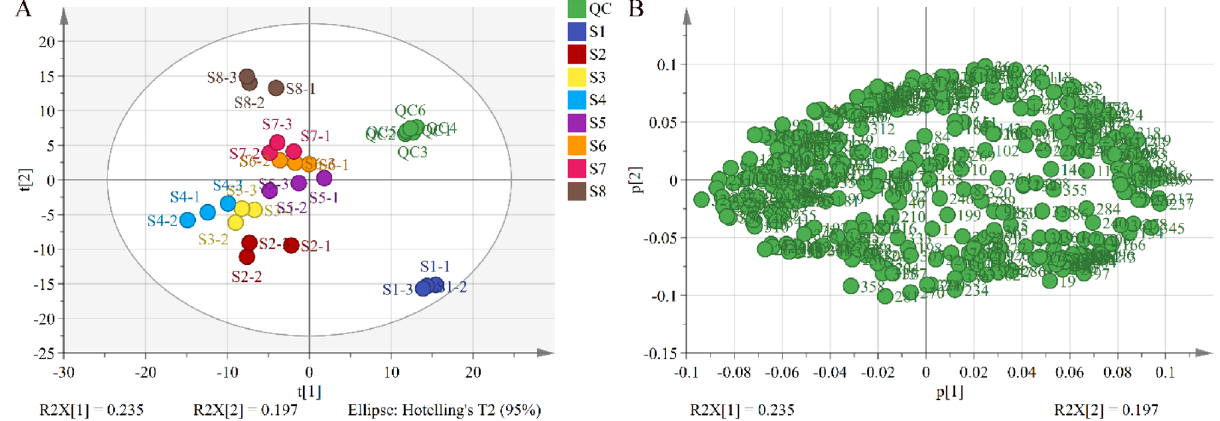
Figure 2. PCA result from soapberry pericarp from different fruit growth stages. Variables used for PCA were 374 putatively identified metabolites by UHPLC-HRMS on the C18 column and HILIC column. Data was auto scaled prior to PCA. ( A ) Scores plot; ( B ) loading